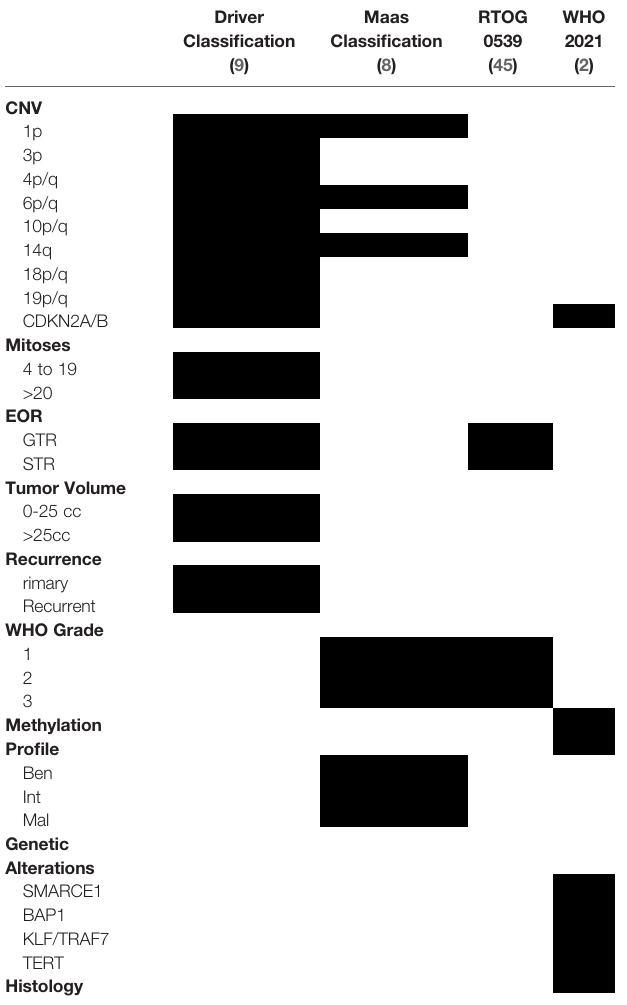
TABLE 2 | Comparison of contemporary aggressive meningioma